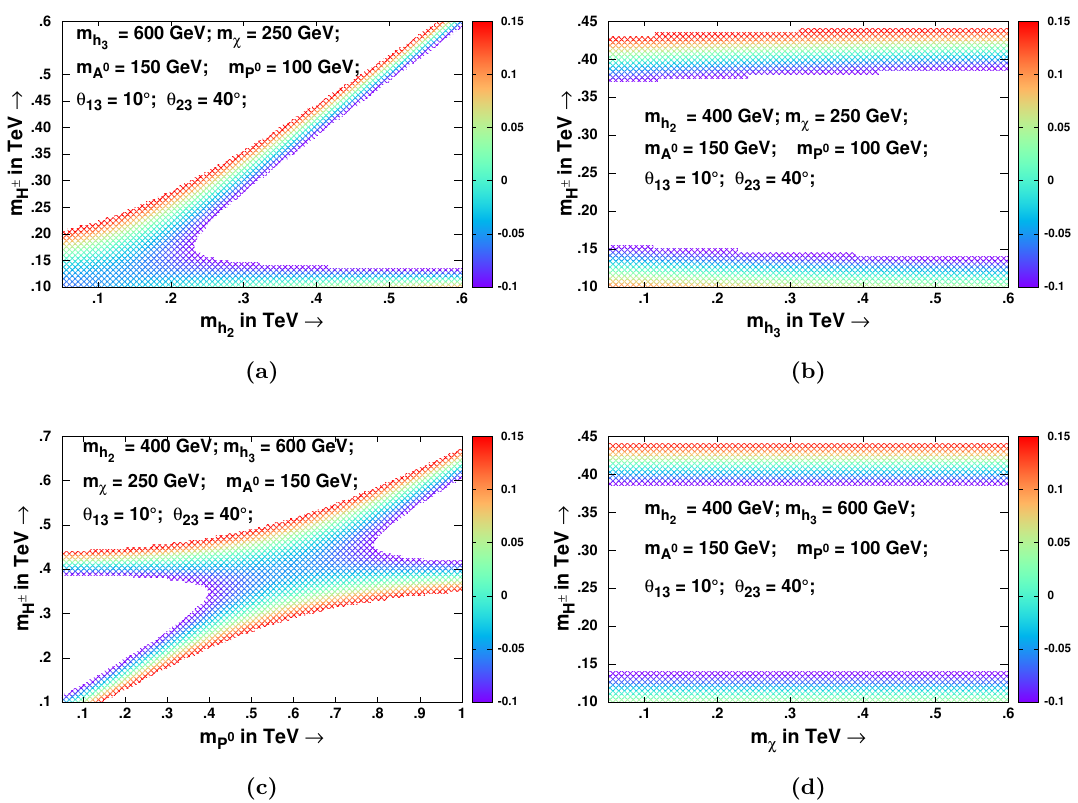
Figure 5. One sigma shaded density maps in the plane defined by respective scalar/ pseudo- scalar/ VLL masses and charged Higgs mass m on precision variable ∆ T = 0 . 03 ± 0 . 12 [59].